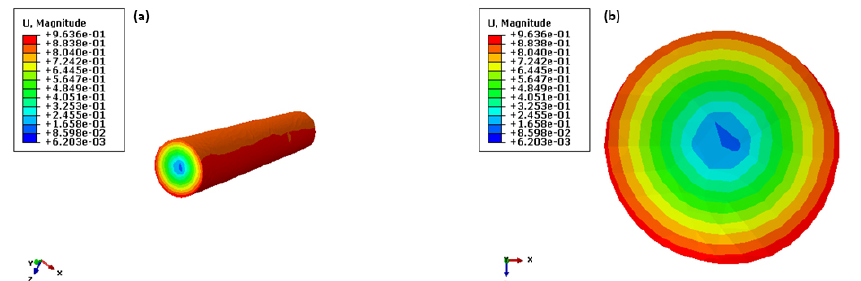
Figure 4. The distribution of the total displacement field: ( a ) intuitive view; ( b ) radial section.